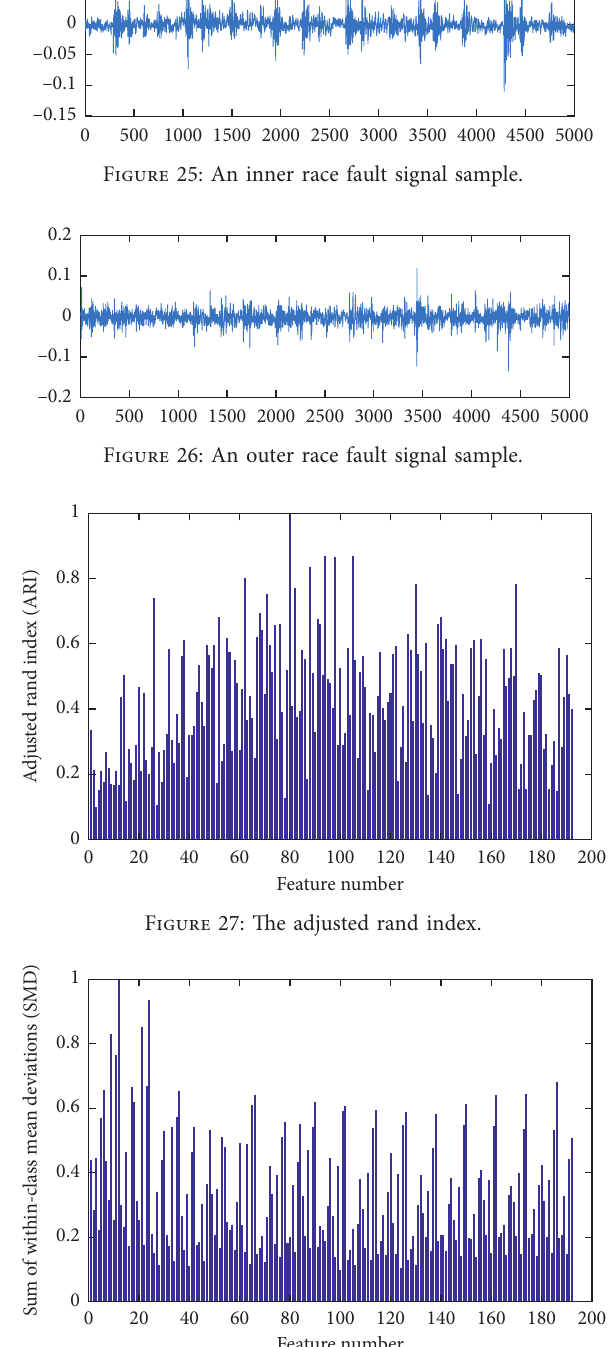
Figure 28: The sum of within-class mean